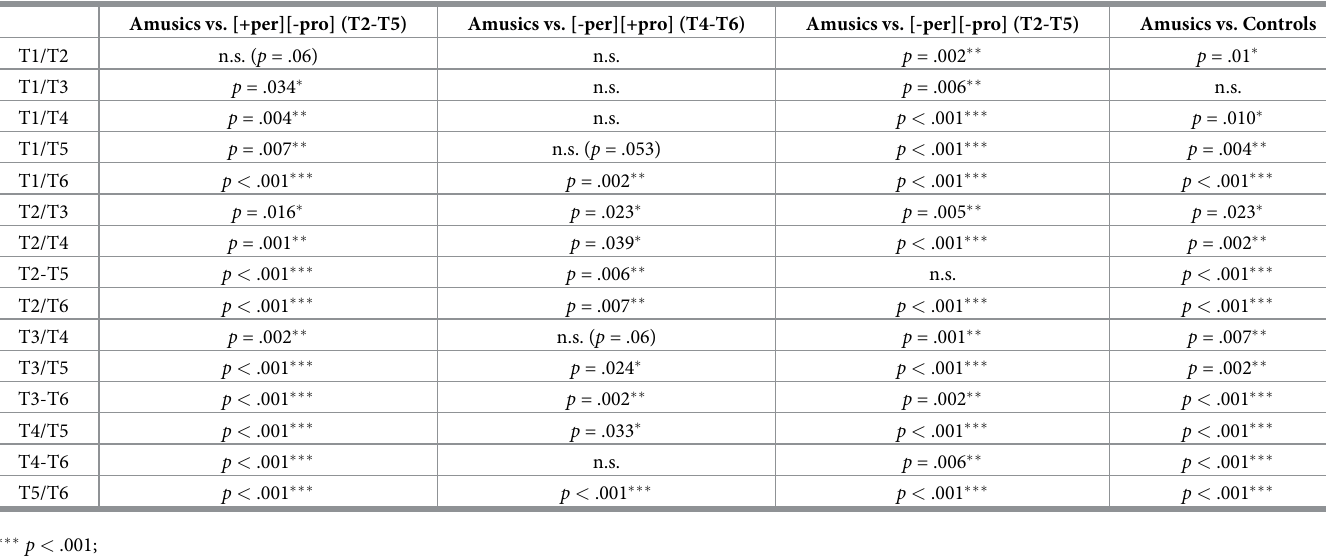
Table 2. Pairwise comparisons of amusics vs. the three tone-merging groups and controls on the d’ scores of the 15 tone pairs in the tone discrimination task. Amusics vs. [+per][-pro] (T2-T5) Amusics vs. [-per][+pro] (T4-T6) Amusics vs. [-per][-pro] (T2-T5) Amusics vs.